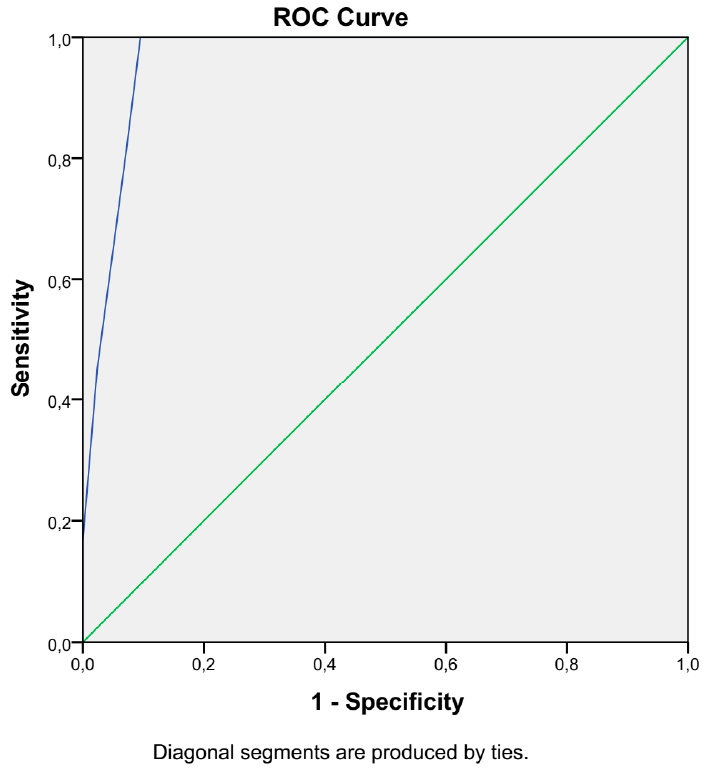
Figure 5. iFC evaluation of gynecological neoplasia is highly sensitive and specific. The results of ROC curve analysis are presented. The horizontal axis represents 1-specificity, and the vertical axis represents sensitivity. The blue line represents the accuracy values, based on both